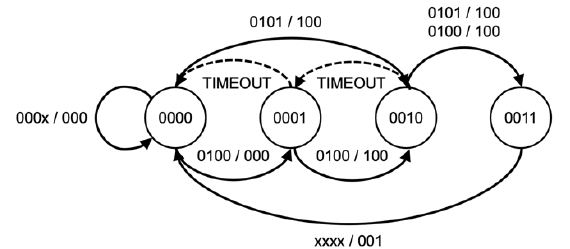
Figure 4. Deauthentication KCSM.